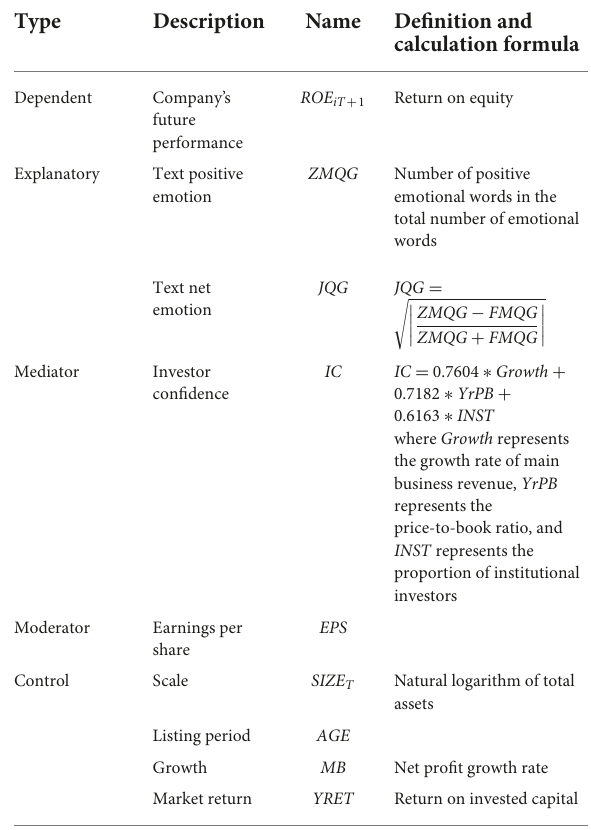
TABLE 3 Variable definitions.